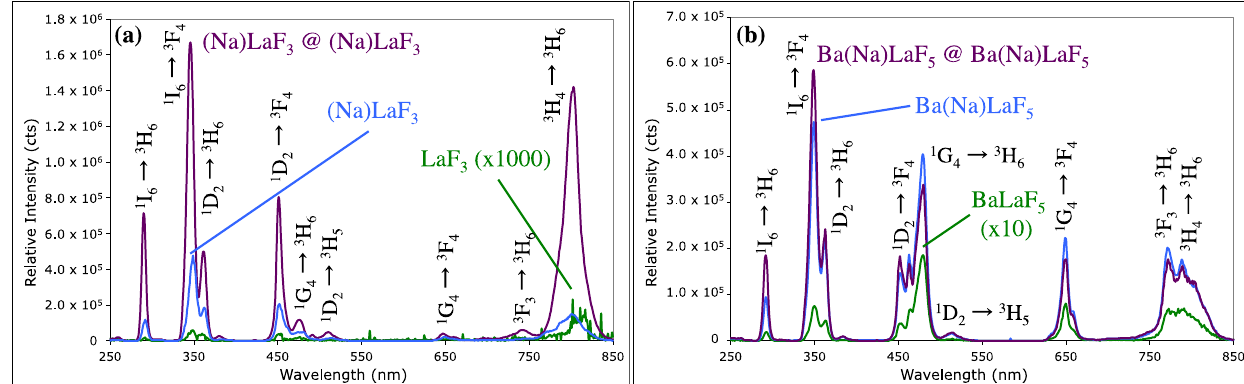
solutions in toluene; 980 nm CW laser excitation; 60 W/cm 2 . Tm 3+ transitions